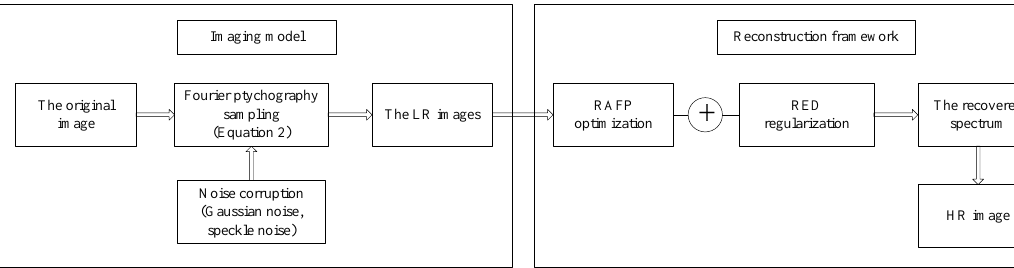
Figure 4. Block scheme of the simulation experiments.